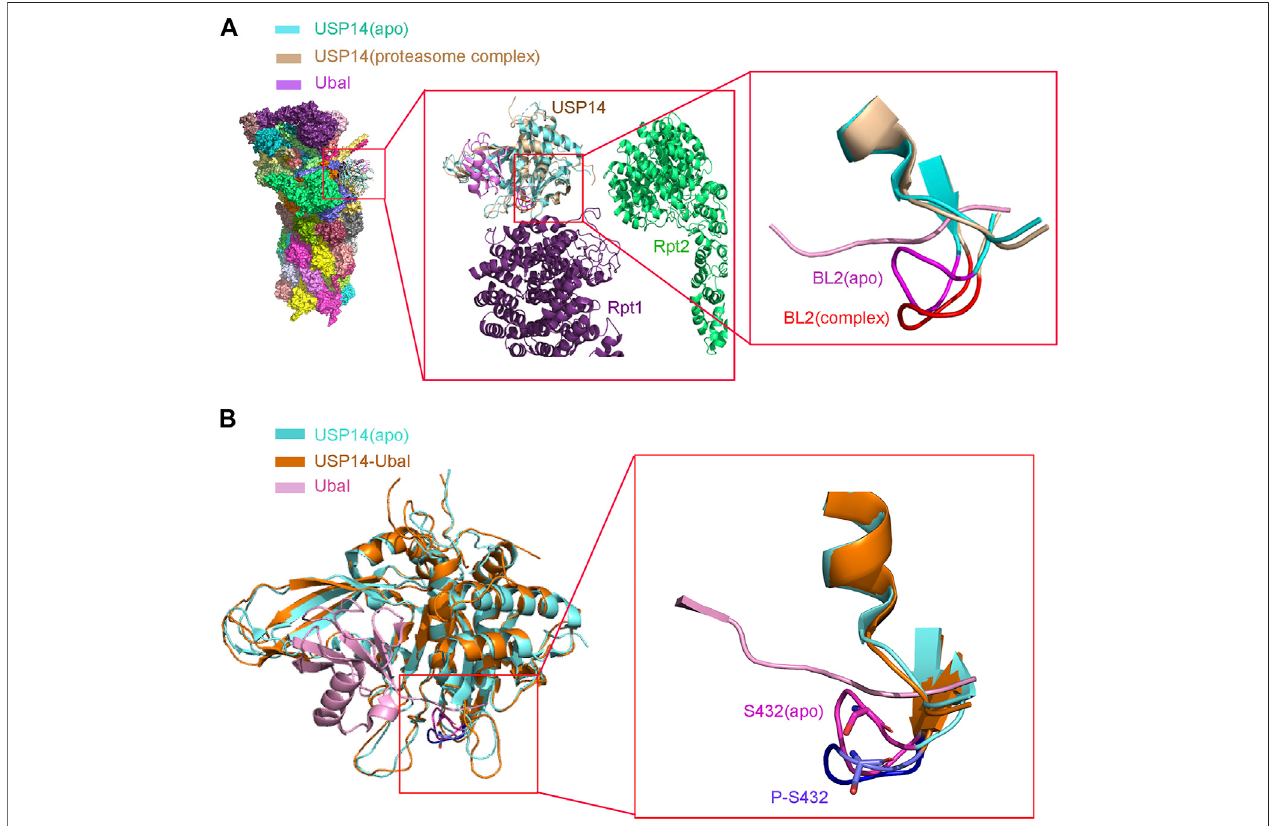
FIGURE2| Structure ofUSP14catalyticdomain regulatedbyproteasomeandphosphorylation. (A) Left:Comparedthestructure ofUSP14betweenUSP14(apo) and 26s proteasome-USP14-Ubal(complex). Middle: Enlarged structure of proteasome-USP14-Ubal. Right: Compared the BL2 between USP14(apo) and 26s proteasome-USP14-Ubal (complex). USP14 in the free and complex are shown in cyan and wheat, respectively. BL2 in the free and complex are shown in magnet and red, respectively. The Ubal is shown in pink. (B) Left: The structure of USP14(apo) and USP14 in complex with Ubal. Right: Compared the BL2 between USP14(apo) P-S432-USP14. Phosphorylation of USP14 at S432 lead similar conformation changes to USP14-Ubal. BL2 in the free and complex are shown in magnet and purple, respectively.